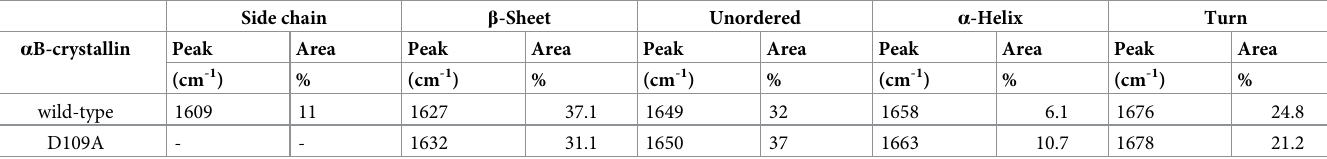
Table 2. The percentage of secondary structure content of different α B-crystallins obtained by FTIR analysis.